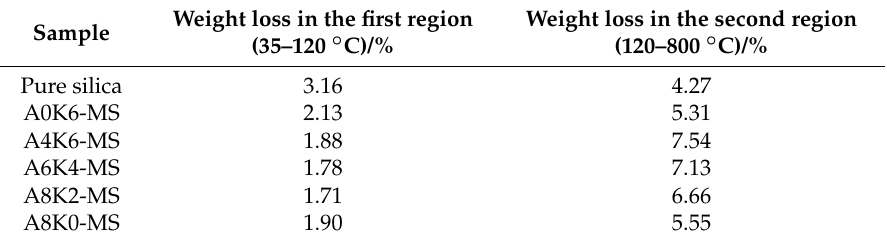
Figure 4. Thermal gravimetric analyzer (TGA) curves of pure silica and all modified silica. Table 4. Weight losses of pure and modified silica in the first and second regions.